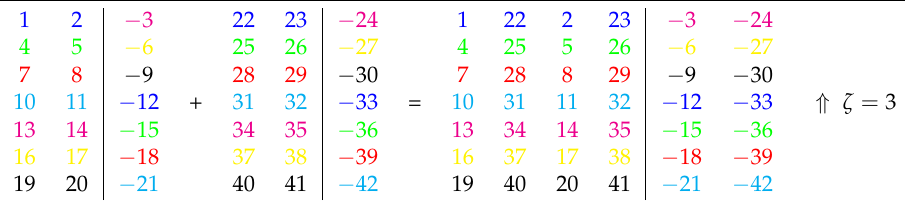
Table 15. Winding Distribution Table for a double layer winding with N = 42, p = 2 and m =